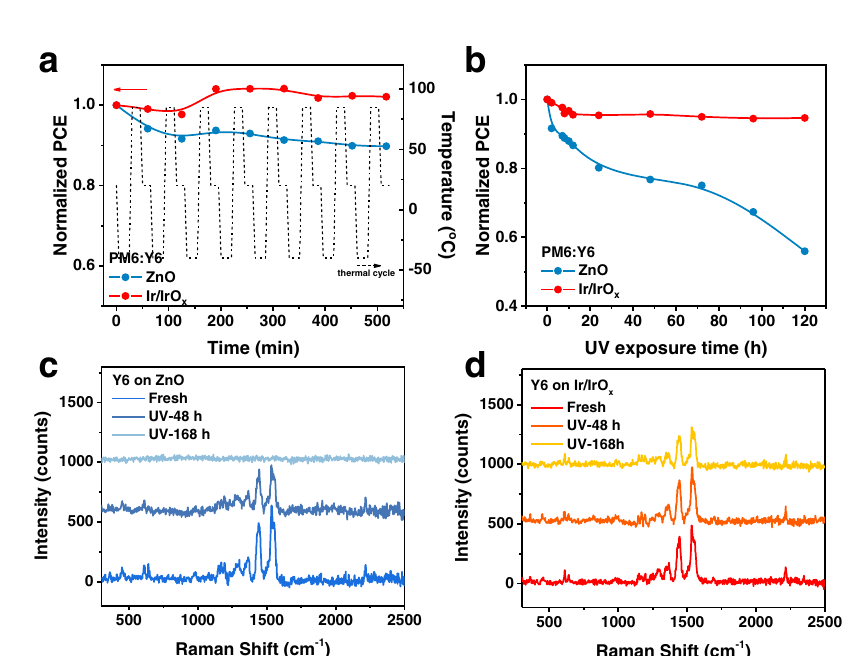
Fig. 7 | Device stability under extreme conditions. a The evolution plots of PCE with thermal-circulation time based on the champion PM6:Y6 devices with differ- entETLs.Thethermal-circulationtestwasperformedwiththestandardISOS-T-3,in whichthetemperaturerangewasfrom − 40 – 85°C. b TheevolutionplotsofPCEwith